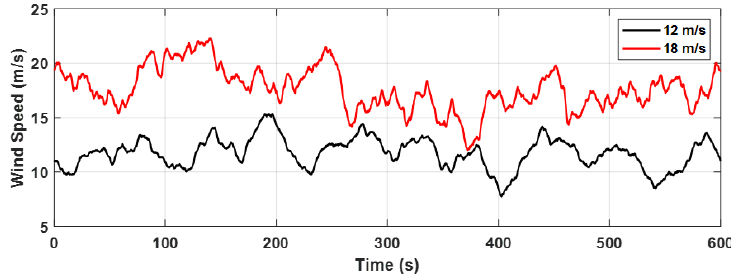
Figure 8. Time-domain diagram at 12 m/s and 18 m/s in NTM.